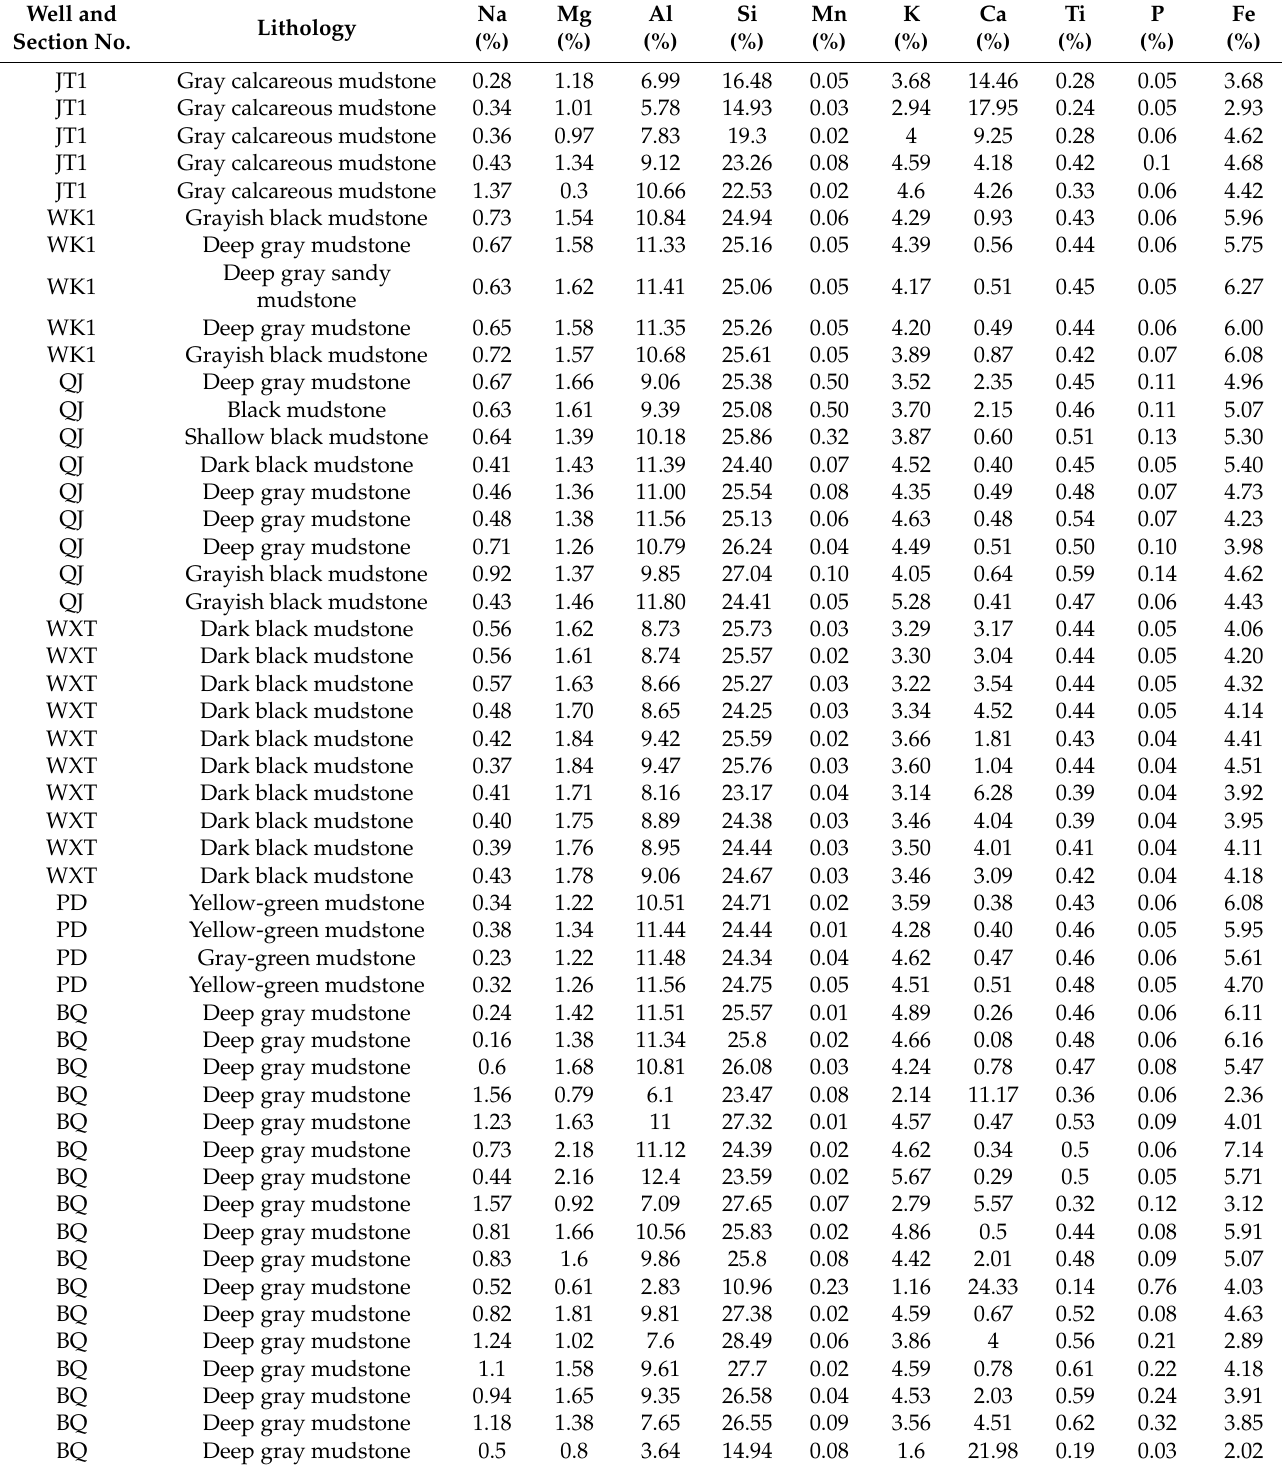
Table 1. Major elements of mudstones in the Meitan